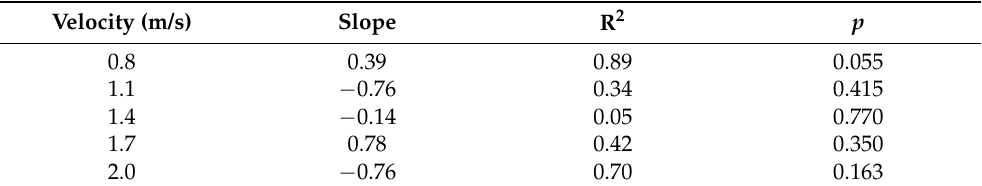
Table 1. Summary of linear regression results for the effect of scouring duration on biomass removal percentage under a certain flow velocity.